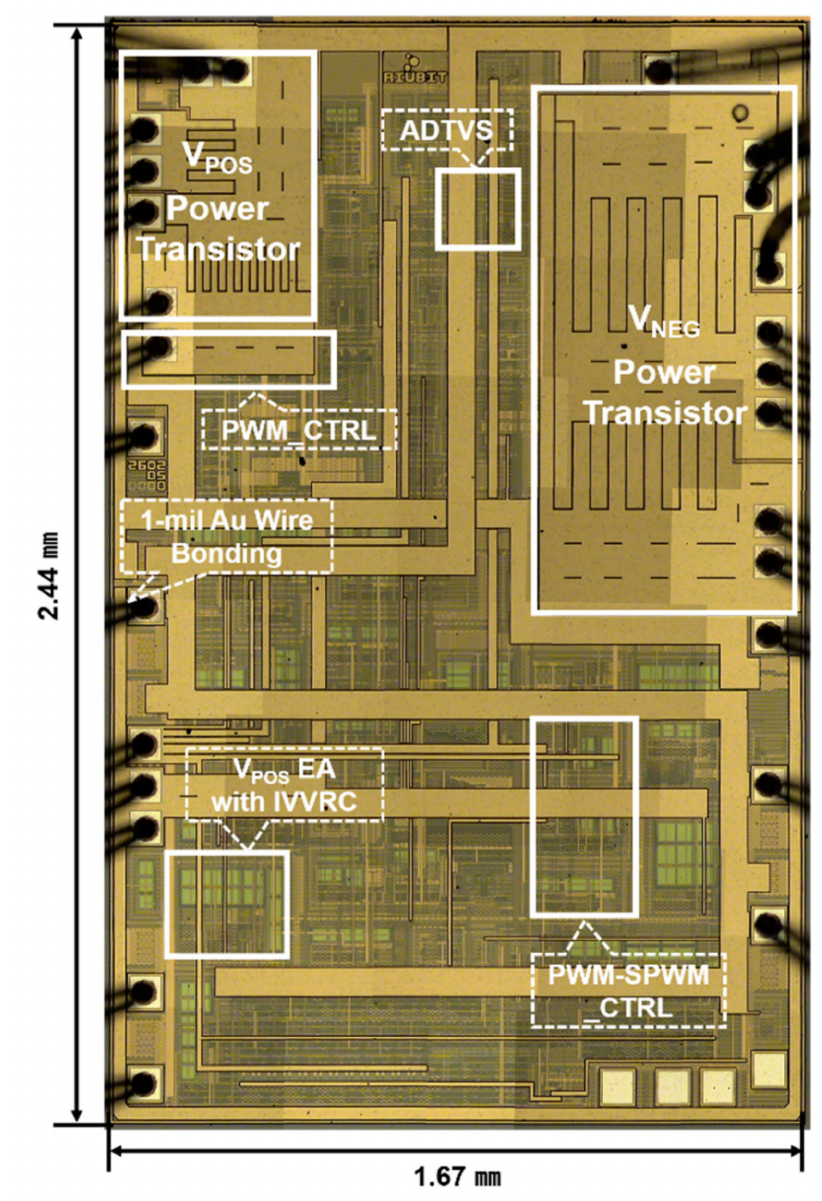
Figure 11. Chip micrograph of the proposed two-channel DC-DC